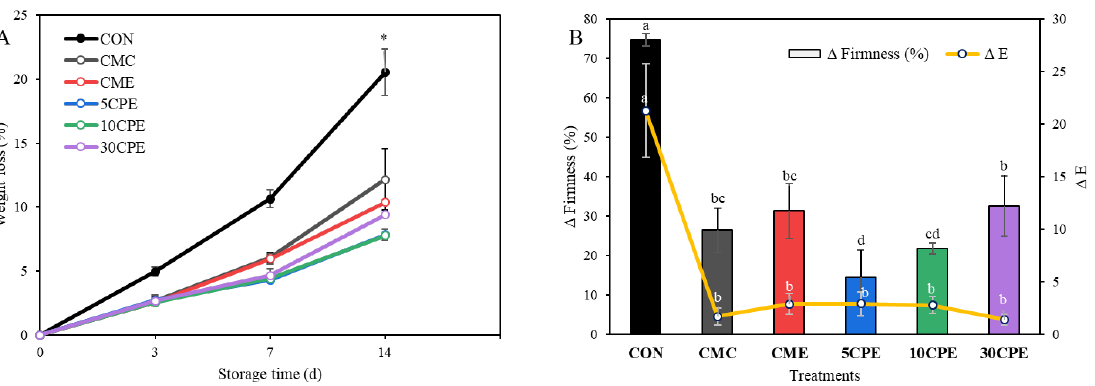
Figure 9. Percentage weight loss ( A ) and changes in color ( ∆ E) and percentage change in firmness ( B ) of uncoated and OLP/CMC-coated cherry tomatoes during storage at 30 ◦ C for 14 days. Values represent mean ± SD ( n = 3), and different superscripts or ‘*’ denotes significant differences (DMRT, p < 0.05). Table 6. Color properties, pH, and firmness of uncoated and OLP/CMC-coated cherry tomatoes.